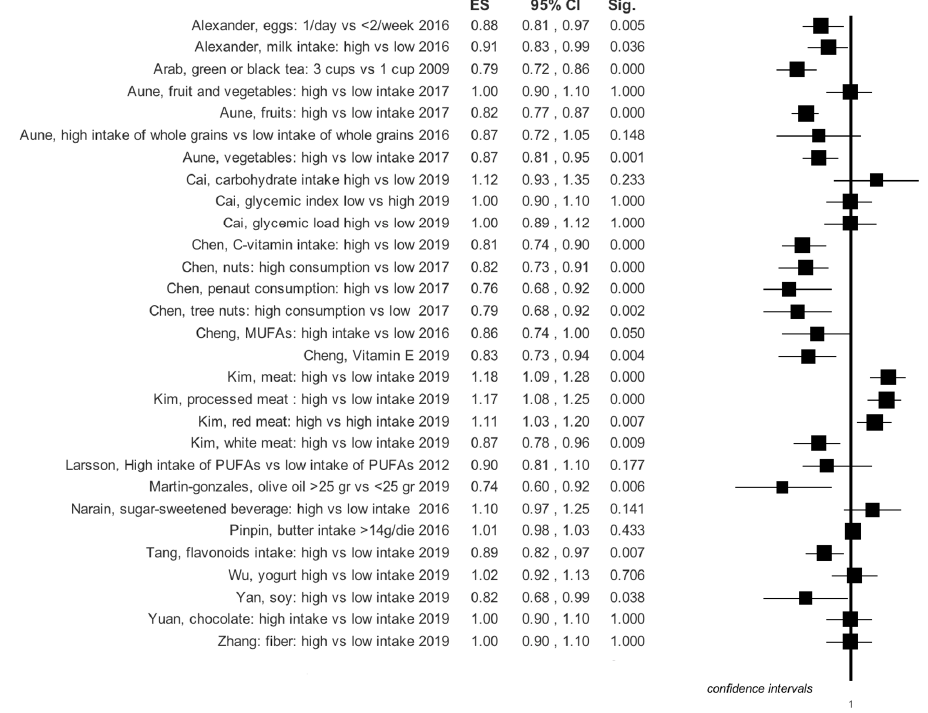
Figure 3. Summary results of effects size for any type of stroke events in observational studies, based on study design of selected primary studies for each meta-analysis.